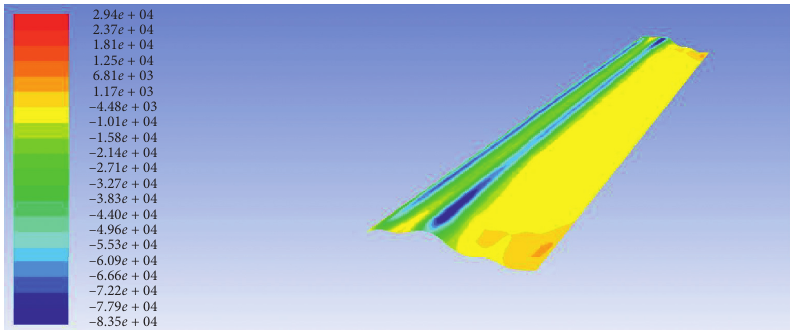
Figure 14: Pressure of the upper surface of the airfoil.